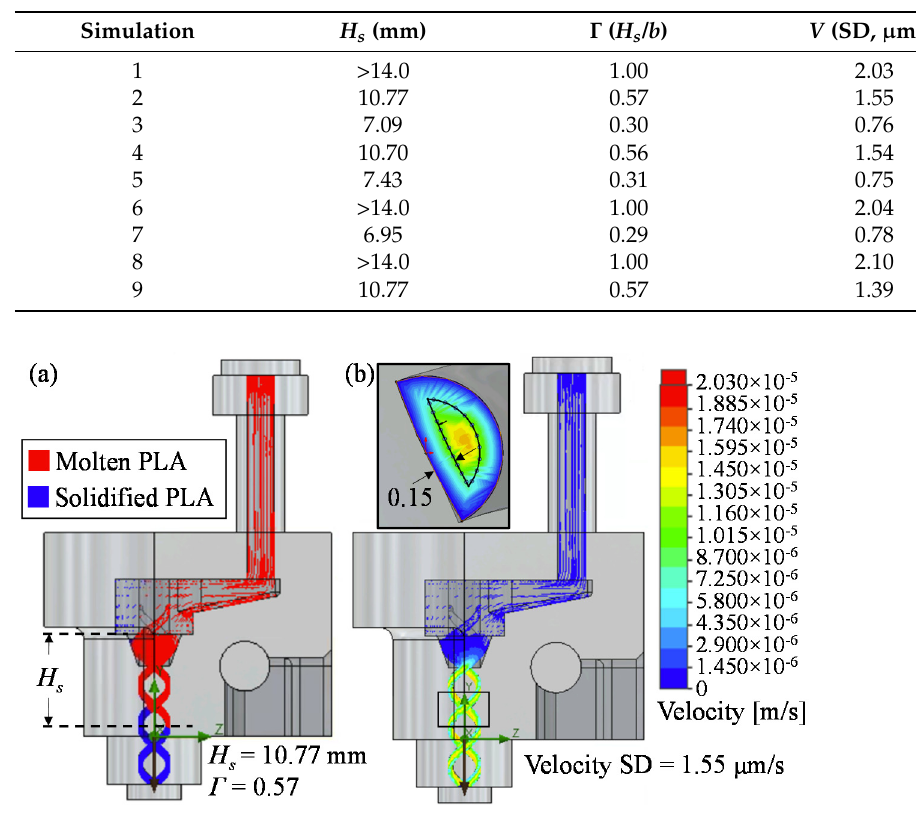
Figure 3. ( a ) Solidification process and ( b ) velocity profile standard deviation of Simulation 2.